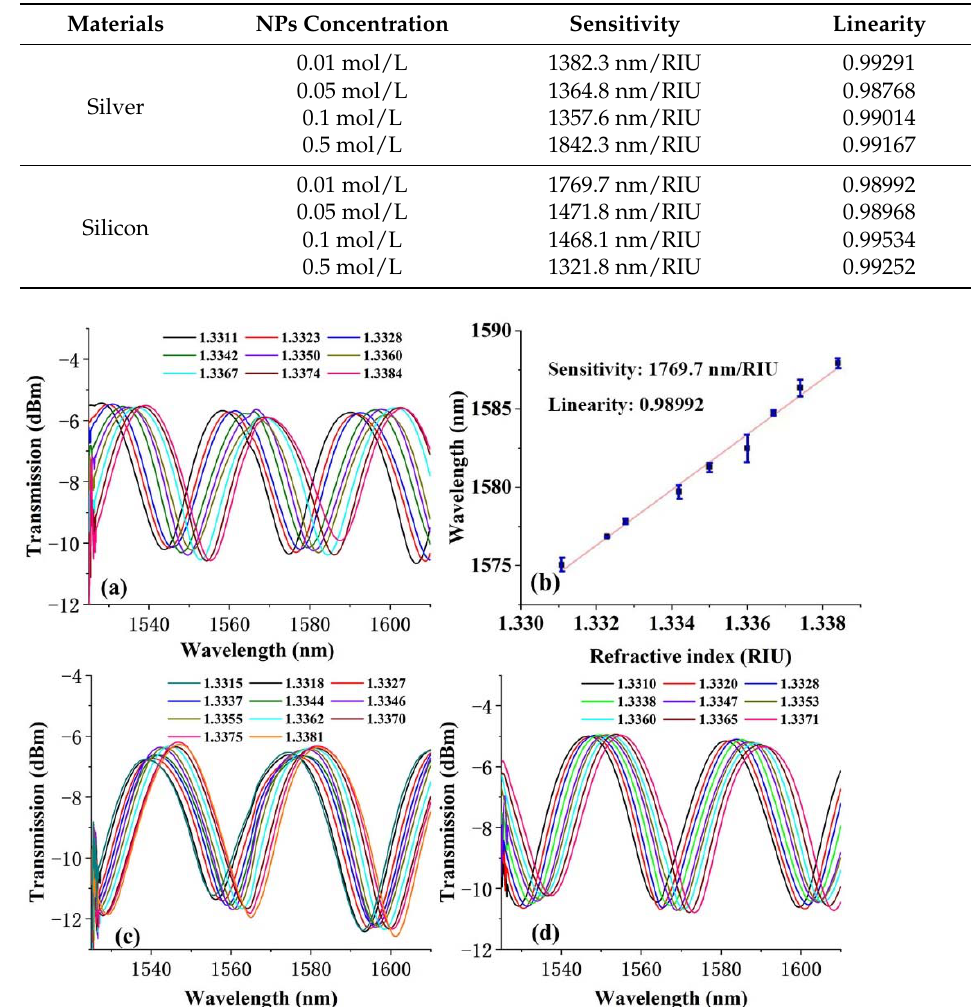
Figure 4. ( a ) Interference spectra and ( b ) responding curve as a function of refractive index for mi- crofiber taper elaborated by silver NPs with concentration of 0.1 mol/mL. Table 1. Sensing performance comparison for 6 mm length of microfiber elaborated by silver and silicon NPs with different concentrations.